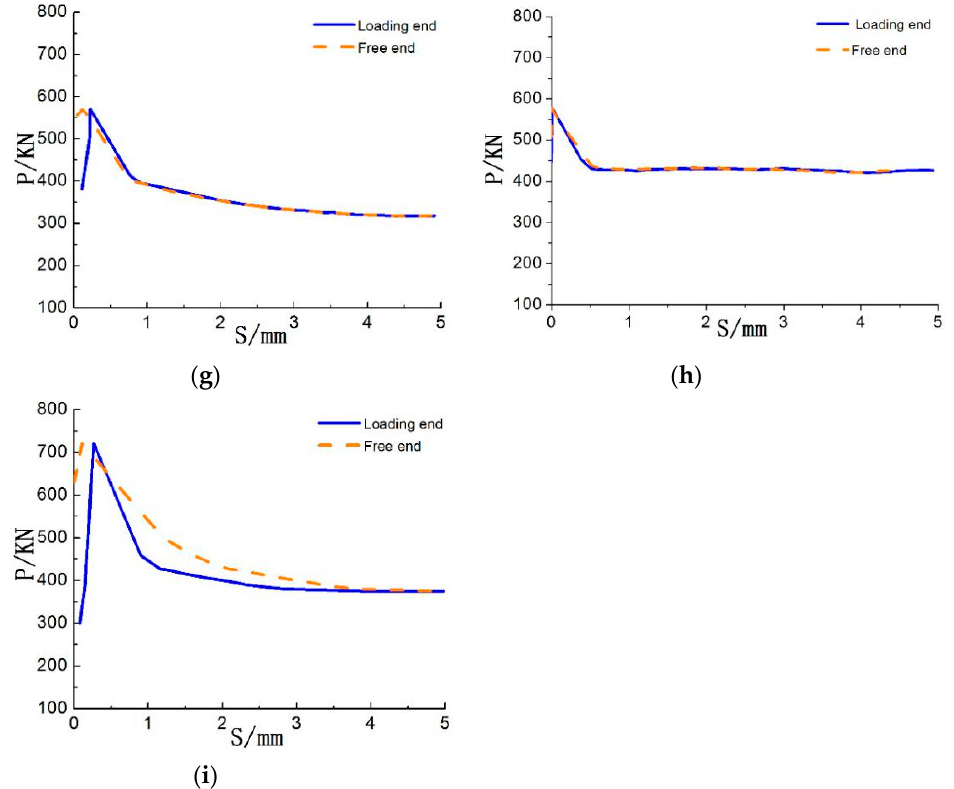
Figure 7. P–S curves of each specimen: ( a ) SRRC-1; ( b ) SRRC-2; ( c ) SRRC-3; ( d ) SRRC-4; ( e ) SRRC-5; ( f ) SRRC-6; ( g ) SRRC-7; ( h ) SRRC-8; ( i ) SRRC-9.